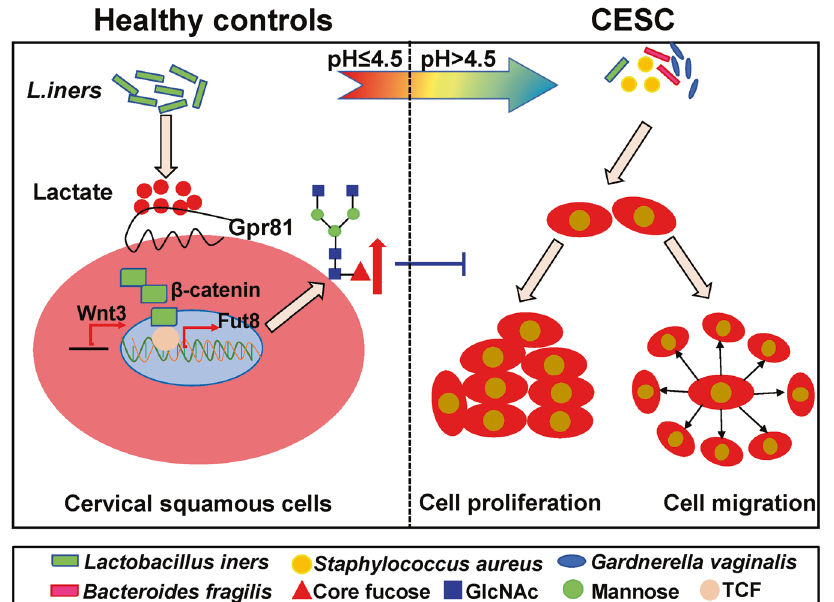
Fig. 7 The molecular mechanism by which Lactobacillus spp. regulate the core fucosylation of epithelial cellsthrough the Wnt pathway. Lactobacillus iners can secrete lactate to increase the level of core fucosylation of epithelial cells by activating the Wnt pathway, which inhibits the proliferation and migration of cervical cancer